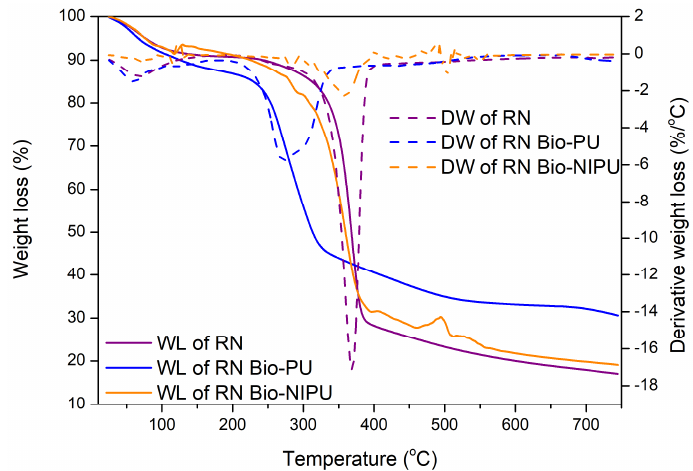
Figure 12. TGA/DTG curves of RN before and after impregnation.